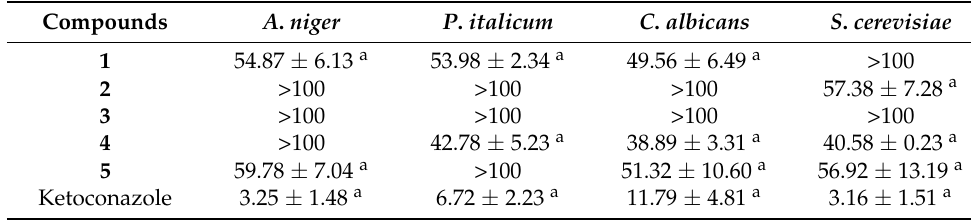
Table 4. MIC values of Compounds 1 – 5 in µ g/mL against four fungi strains.